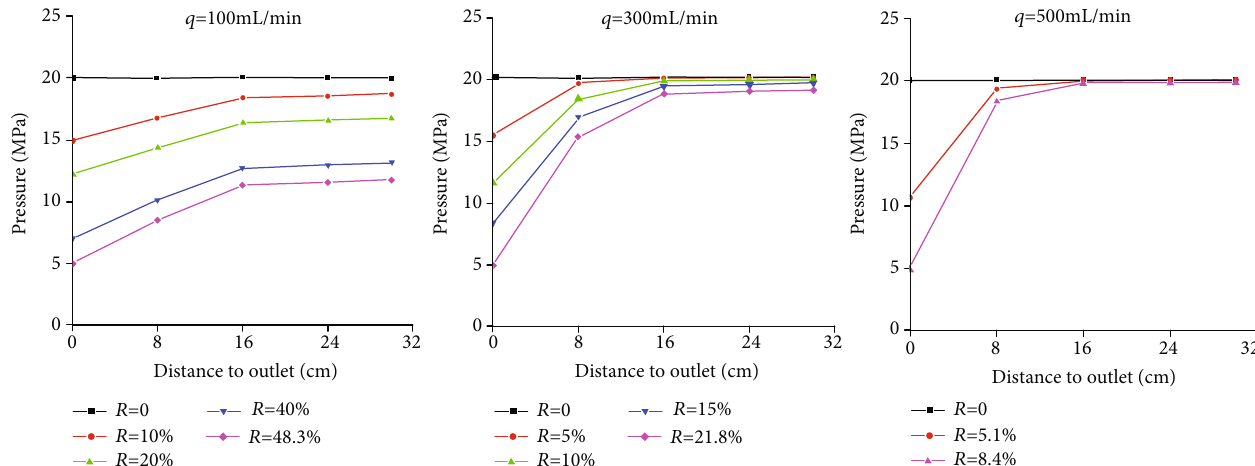
Figure 7: Comparisons of reservoir utilization in the Su3 core under di ff erent gas production